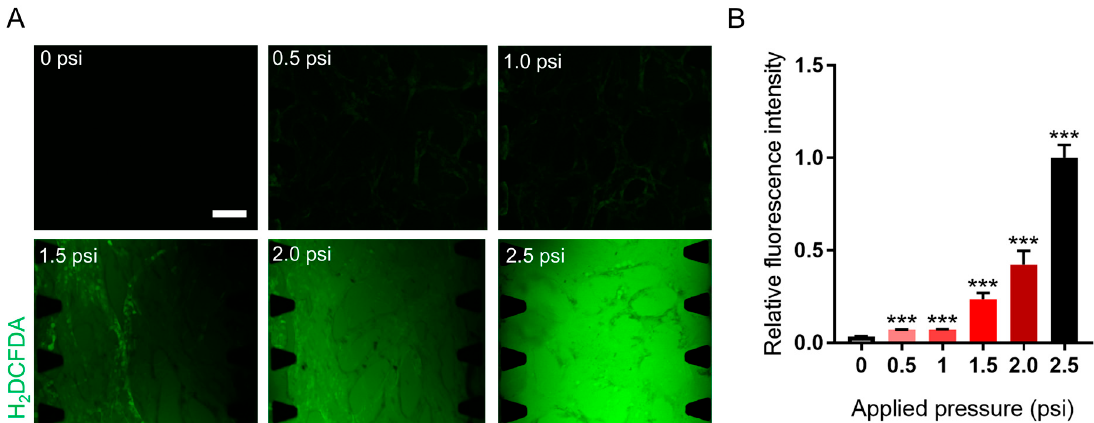
Figure 6. The reactive oxygen species (ROS) level in a microvascular network. ( A ) ROS levels assayed using H 2 DCFDA fluorescence dye (green). Scale bar: 80 µ m. ( B ) Quantitative analysis of the fluorescence intensity. Bars represent the mean ± SEM from 4–5 devices per condition. *** p < 0.001 in an unpaired two-tailed Student’s t -test.